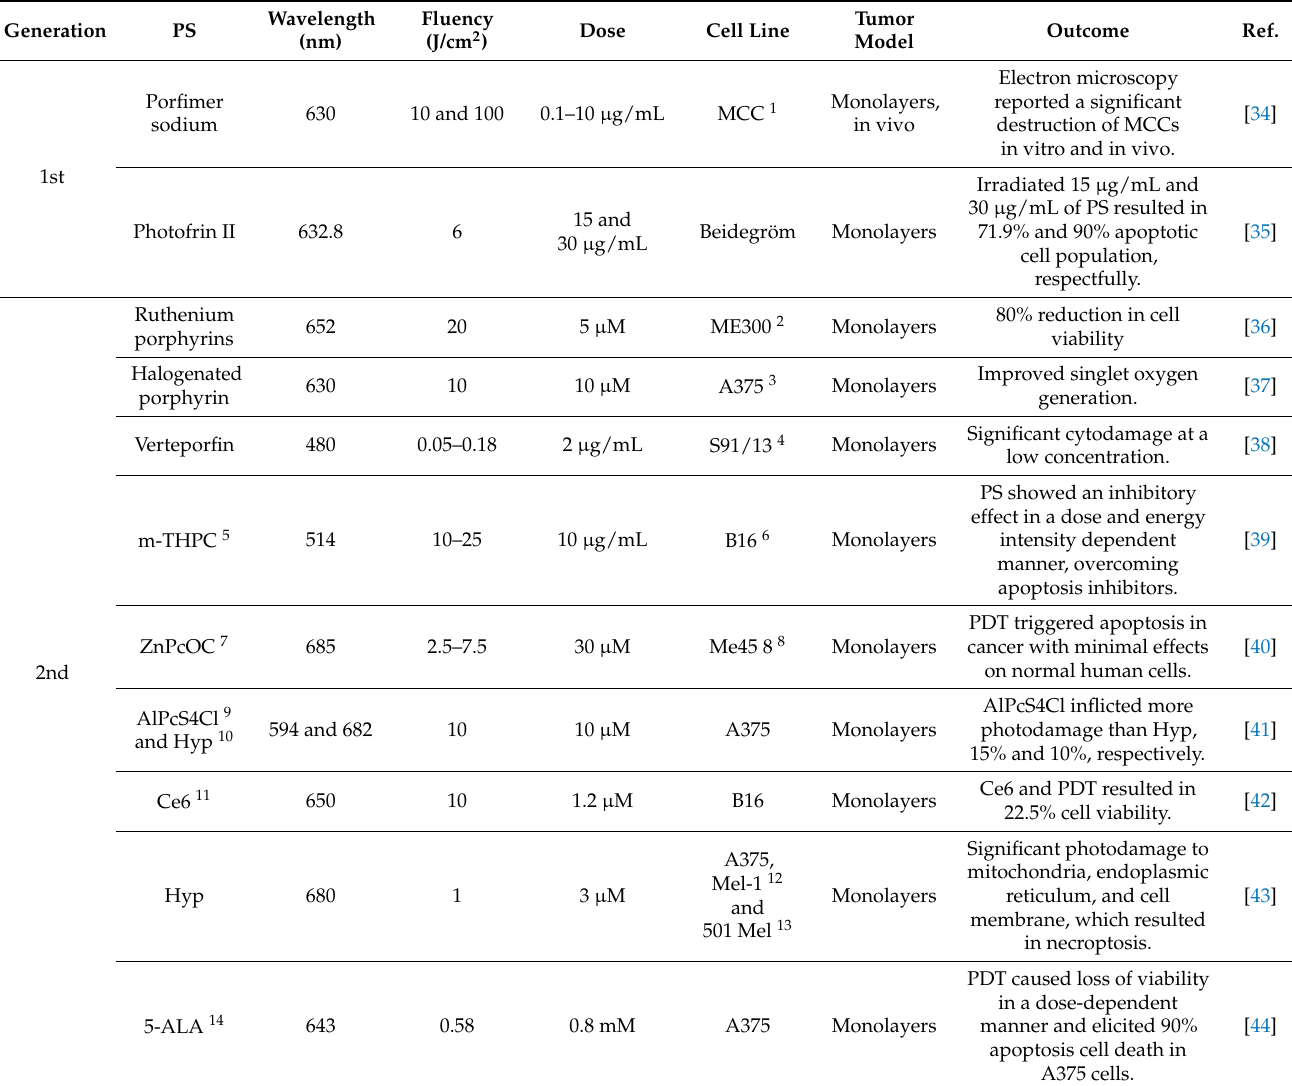
Table 1. Studies of various conventional PSs used in the PDT treatment of